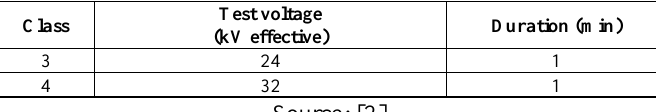
Table 3: Voltages and test times specified for rigid covers.